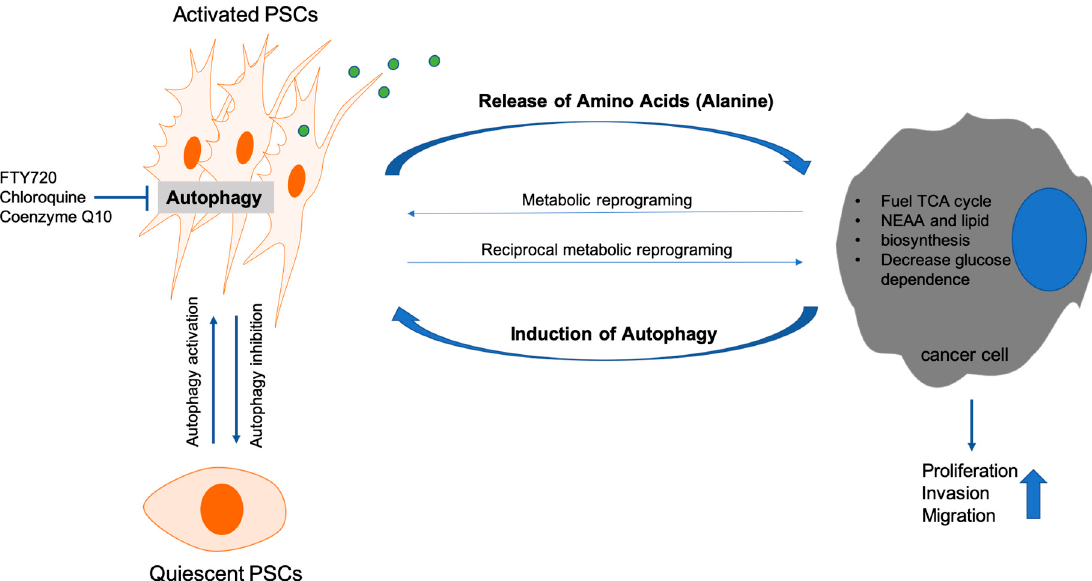
Figure 2. Intratumoral crosstalk between pancreatic stellate cells and pancreatic cancer cells. PSCs, pancreatic stellate cells; TCA, tricarboxylic acid cycle; NEAA, non-essential amino acids.